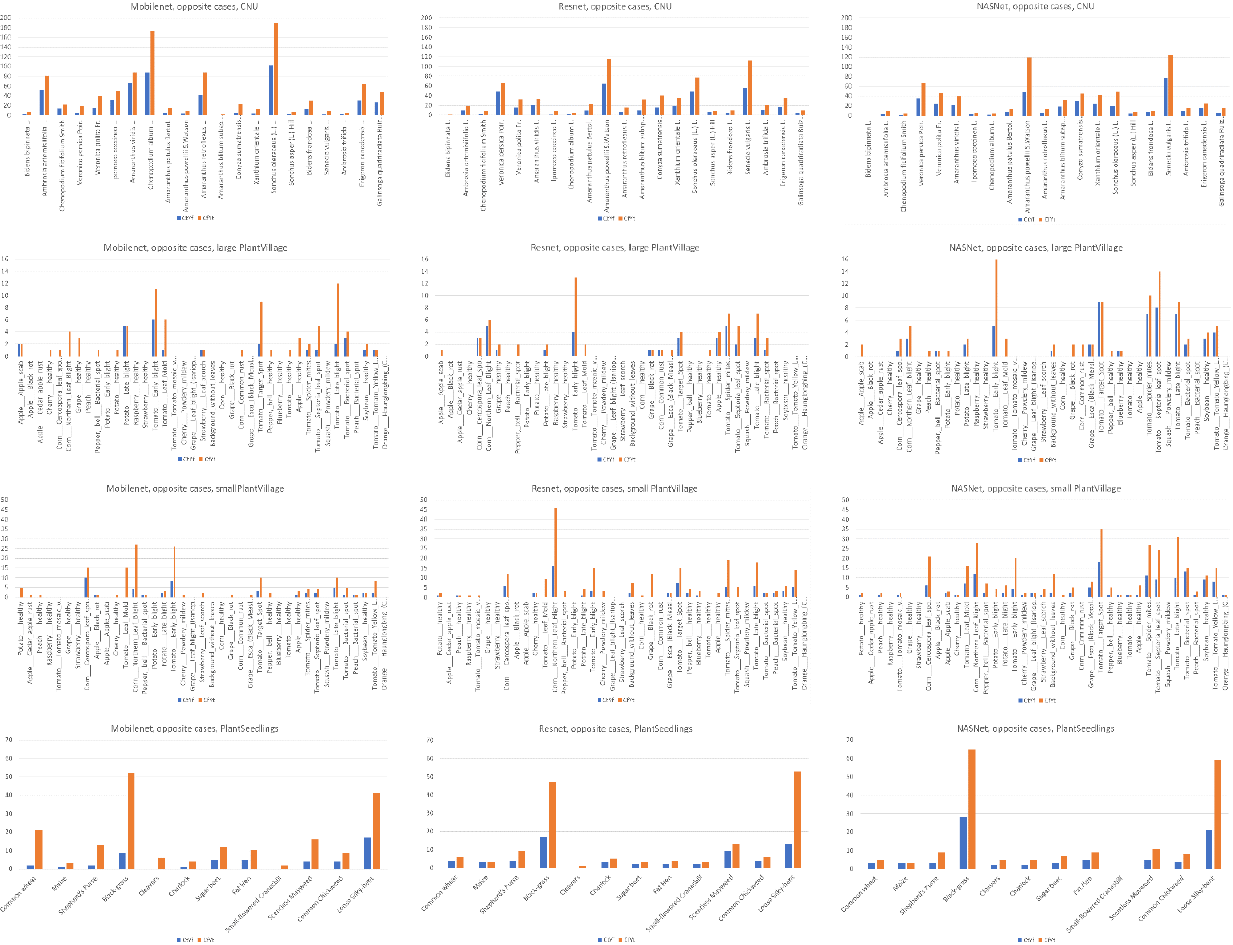
Figure 23. Number of images that were correctly classified using conventional training method but incorrectly classified using YMufT (CtYf), and vice versa (CfYt).